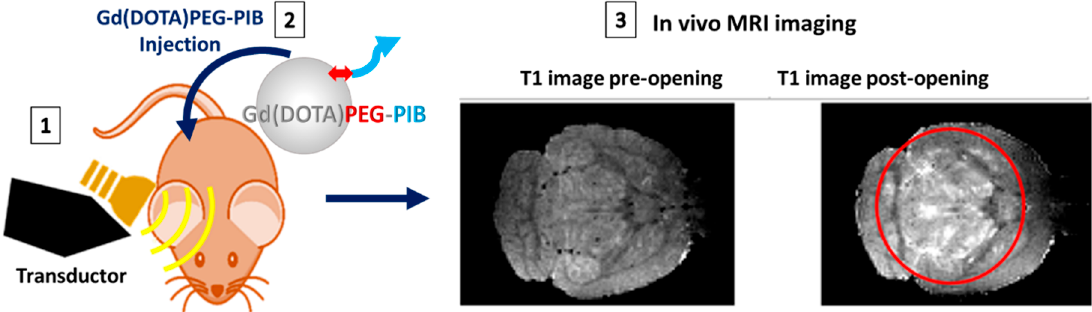
Figure 4. Ultrasound technology was applied via a transductor ( 1 ) on the brain of a transgenic mouse model of Alzheimer's disease (APP/PS1 Δ E9) in order to increase the delivery of Gd(DOTA) grafted with PIB (Gd(DOTA)PEG-PIB) previously intravenously injected ( 2 ). The method consists of sonicating a large part of the brain, allowing for BBB disruption with a global intensity and on a high volume of brain, as observed in the post-ultrasound image compared to the prefrontal cortex (~+20%): MRI images show T 1 -weighted images pre- and post-BBB opening along with injection of Gd(DOTA)PEG-PIB ( 3 ). The MNPs signal appears as a hypersignal affecting the T 1 relaxation time.